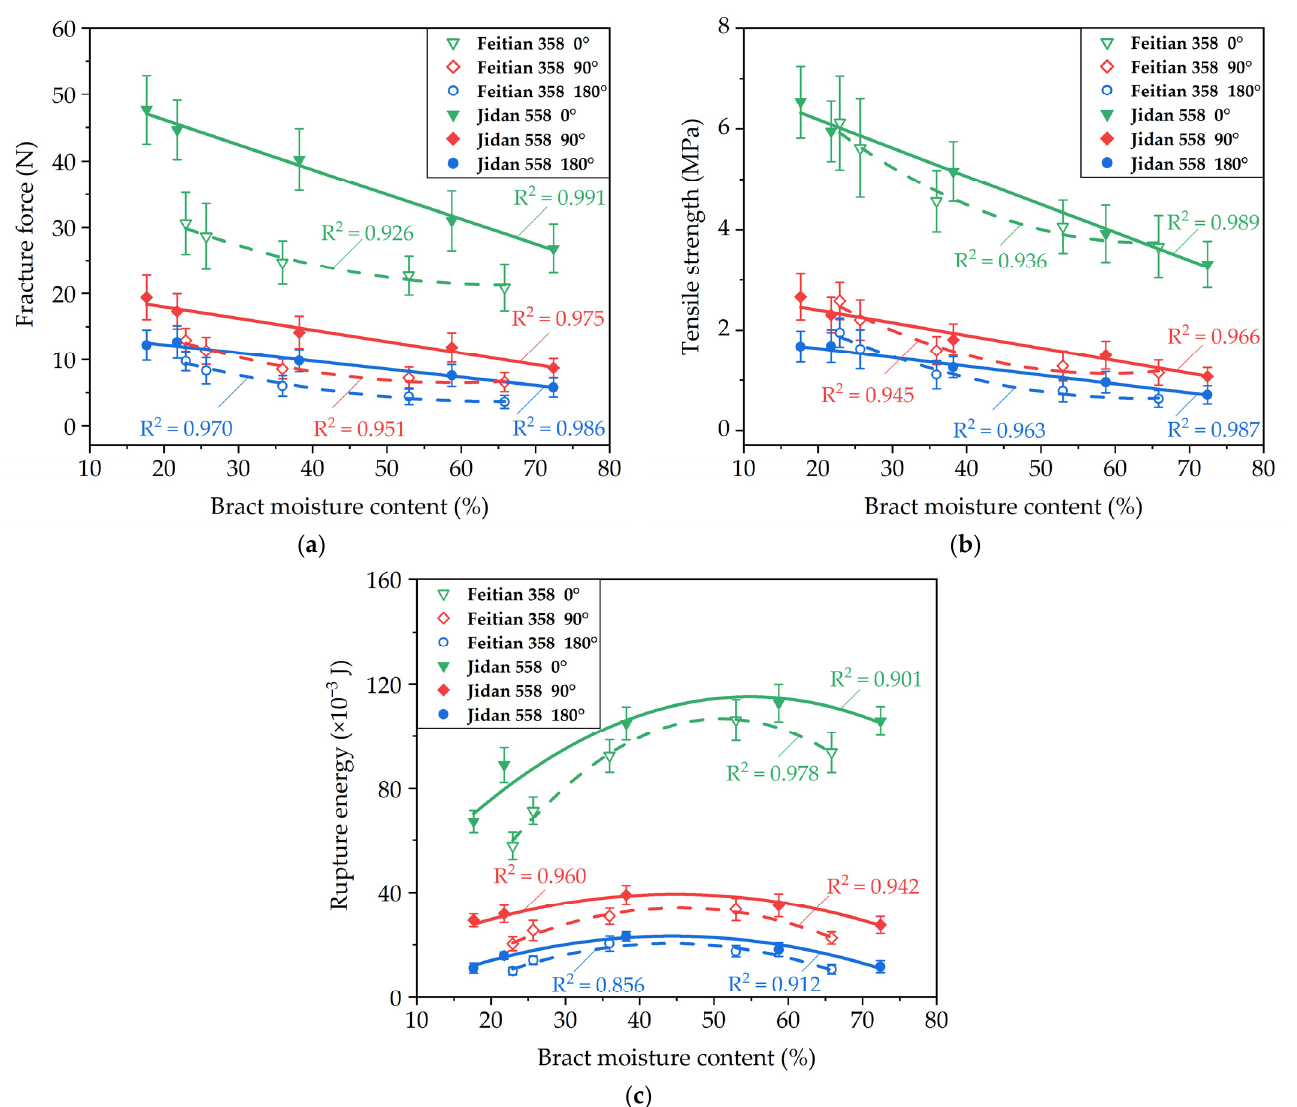
Figure 5. Relationships between tensile properties and moisture content: ( a ) fracture force; ( b ) tensile strength; ( c ) fracture energy.